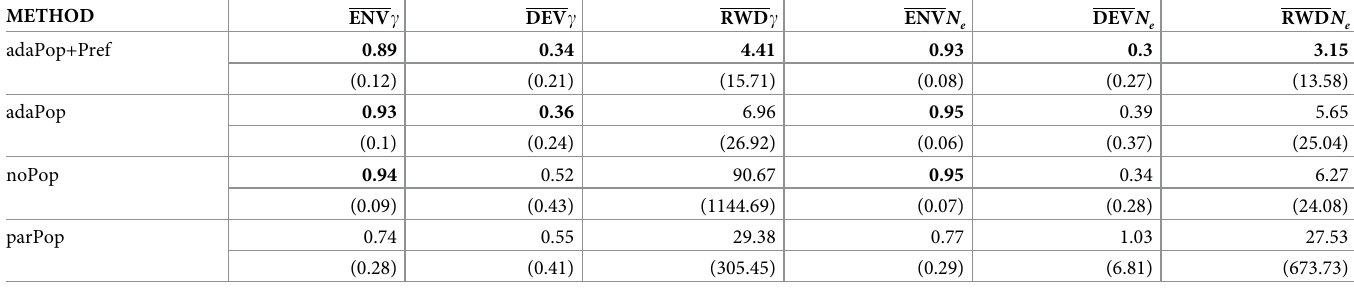
Table 1. Summary statistics of posterior inference of γ , N A , and N B . Each entry is computed as the mean of the performance metrics considered across all synthetic data- e e sets: six possible scenarios for ð N A ; N B Þ , and 100 datasets per a scenario. The metrics for N A and N B have also been averaged. Numbers in parentheses are the standard devi- e e e e ation of each estimate. The numbers in bold indicate the method(s) with the best performance (and within 10% of the best) for each performance metric: the highest for ENV and the lowest for DEV and